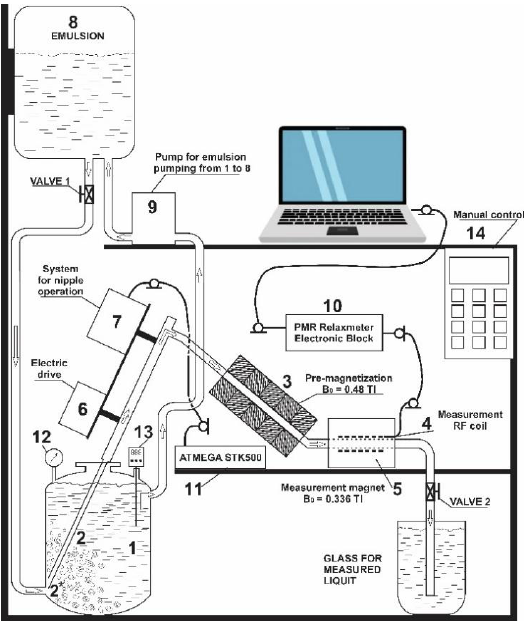
Figure 1. Structural diagram of the testing ground of automated measurement complex.